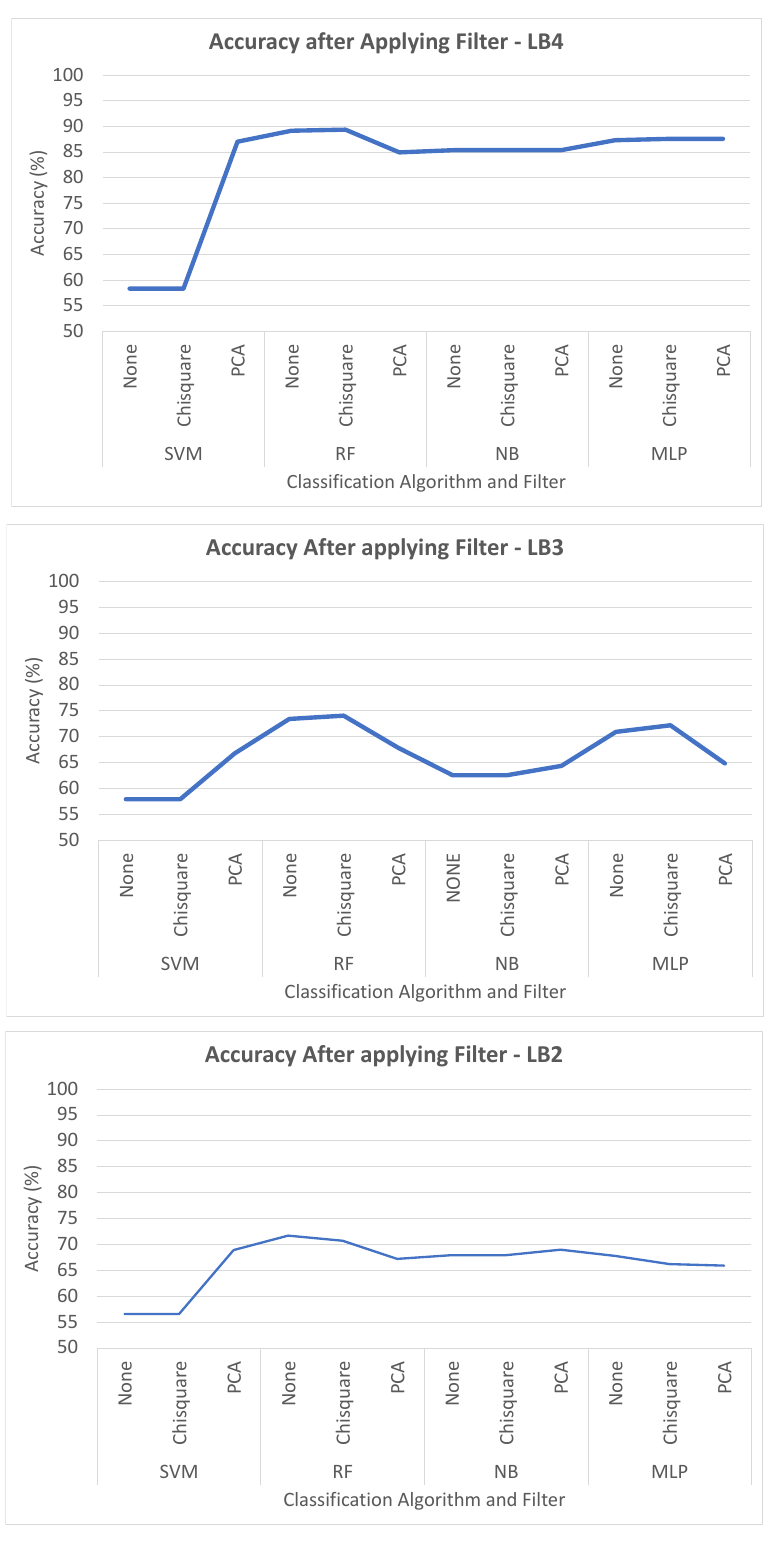
Figure 10. Classification Accuracy with pre-processing—LB2, LB3 and